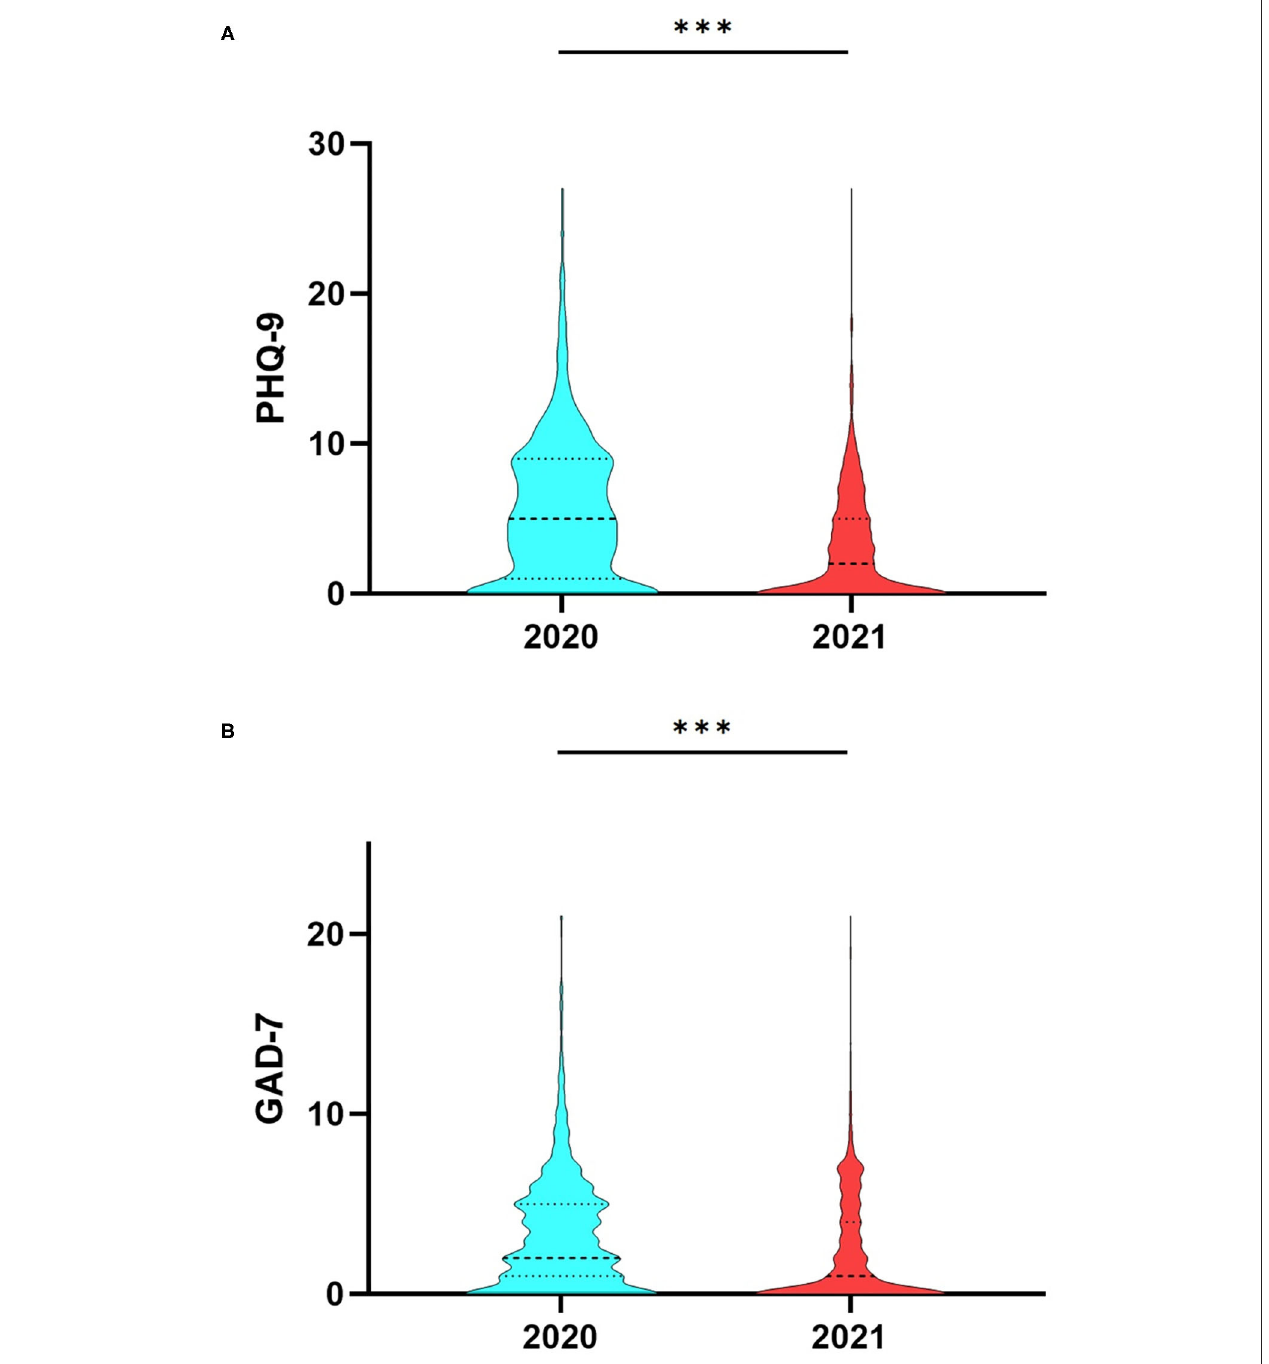
FIGURE 1 | (A) PHQ-9 and (B) GAD-7 differences between the students in 2020 and the students in 2021. PHQ-9, Patient Health Questionnaire 9-item; GAD-7, Generalized Anxiety Disorder scale. *** P < 0.0001.